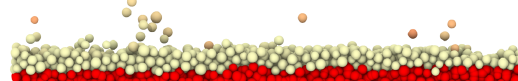
Figure 6. A snapshot from the DEM simulation with an erodible layer of sand (yellow particles) on the rough non-erodible surface (red